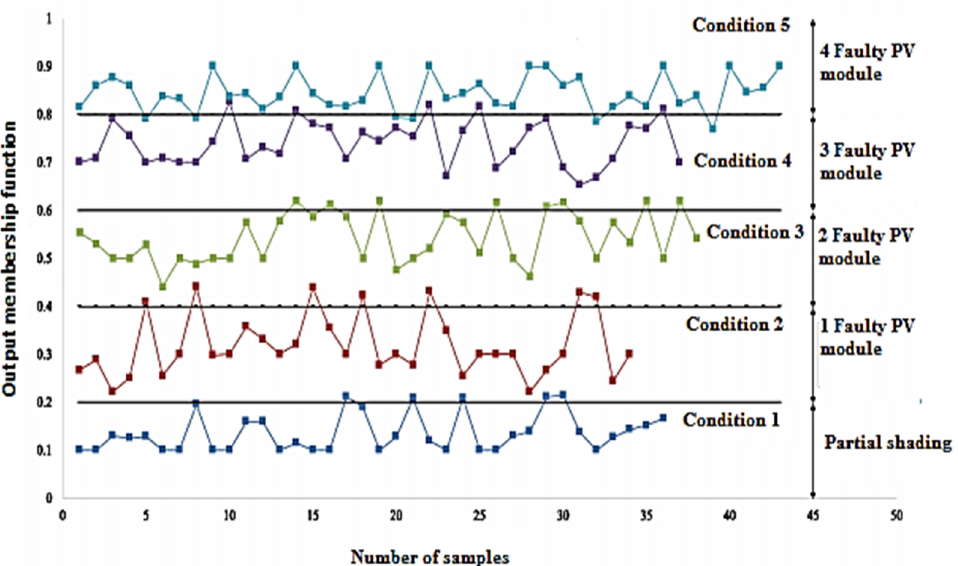
Figure 6. Faulty detection in PV.